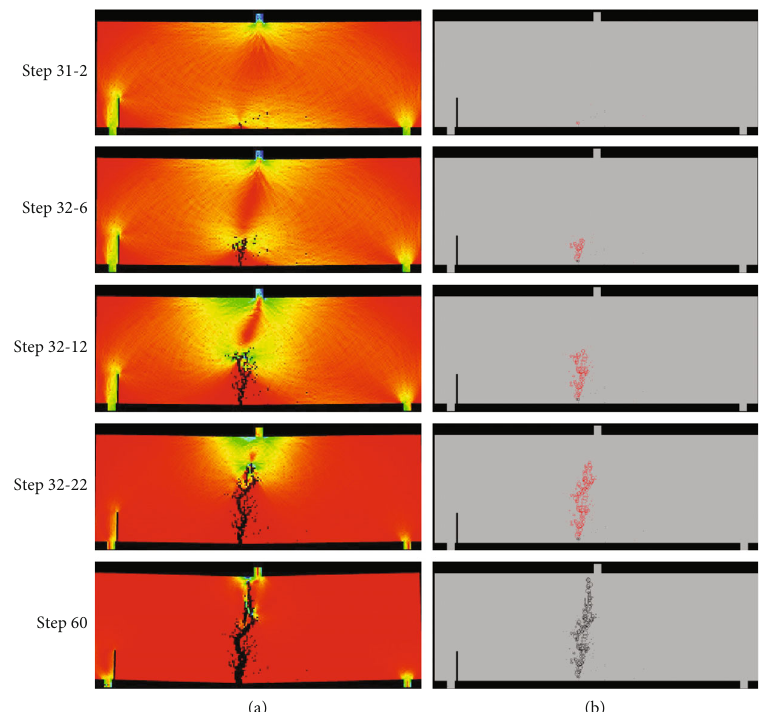
Figure 6: The failure process of a = 90 mm beam: (a) the stress cloud diagram; (b) the acoustic emission diagram.